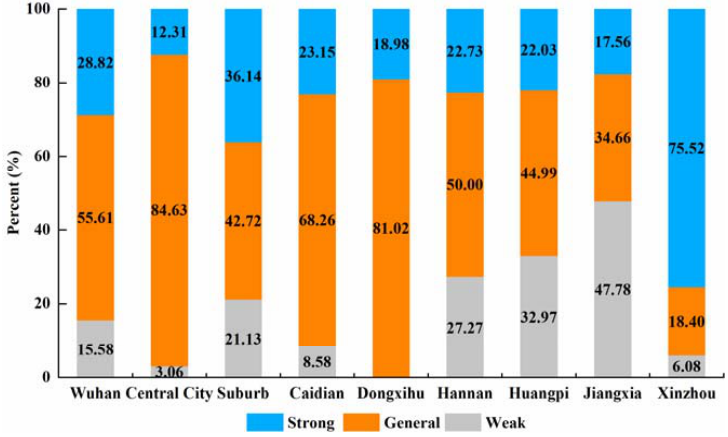
Figure 6. Aged care service capability in Wuhan.